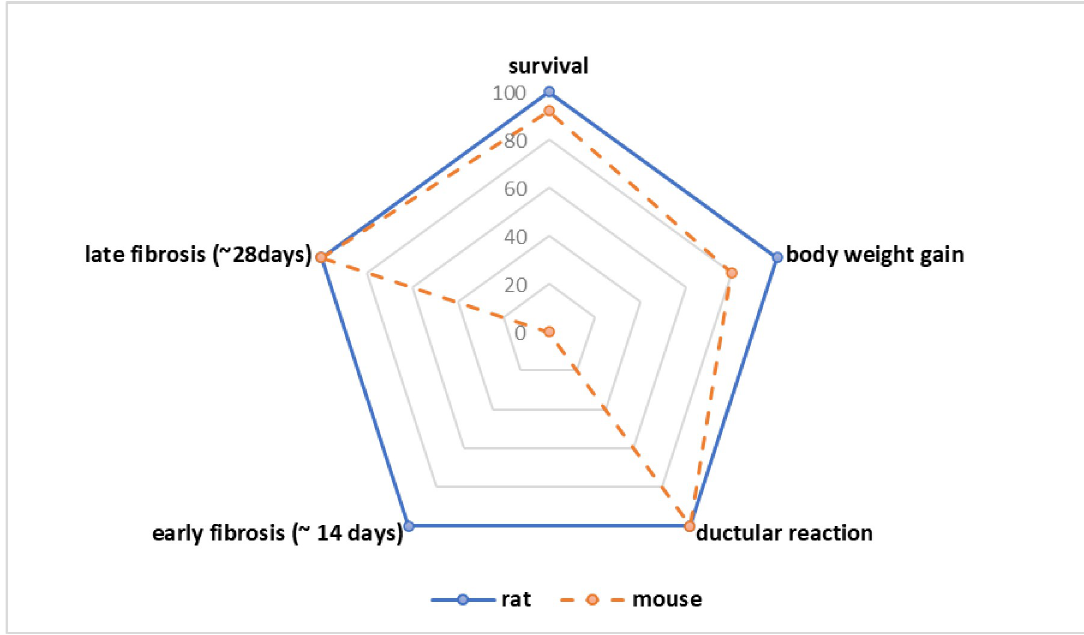
Fig 6. Comparison of the differences in essential parameters for selecting the appropriate species (rat vs. mouse) in cholestatic research.